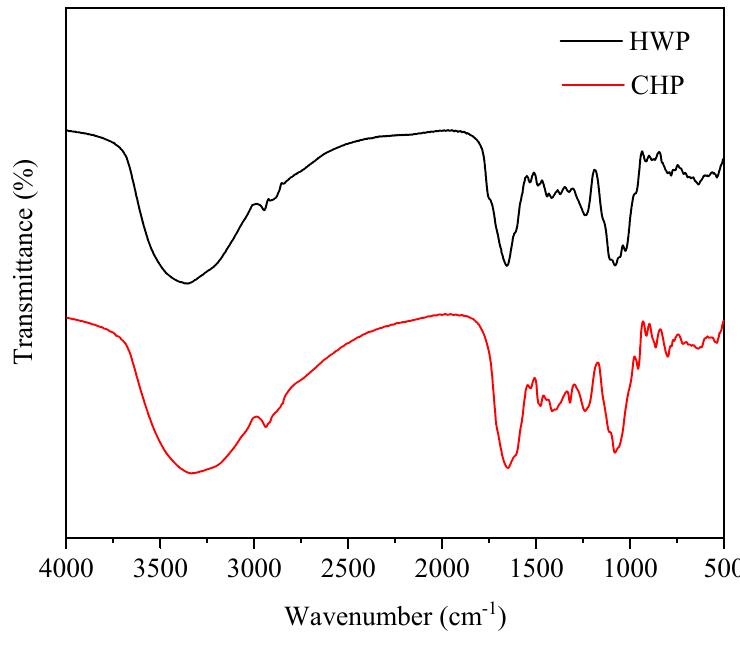
Figure 3. FT-IR spectra of HWP and CHP.